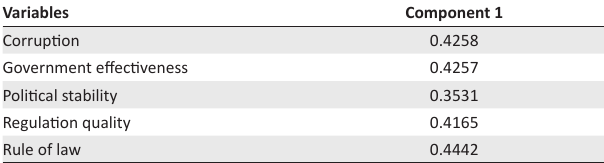
TABLE 3: Components score coefficient matrix.